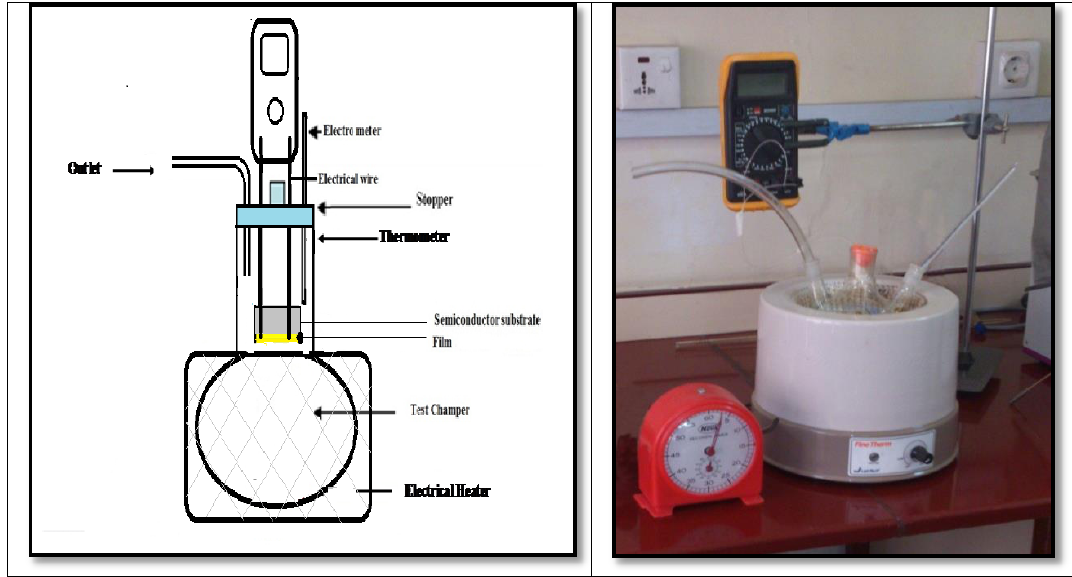
Fig. 1: Gas detection measurement system.